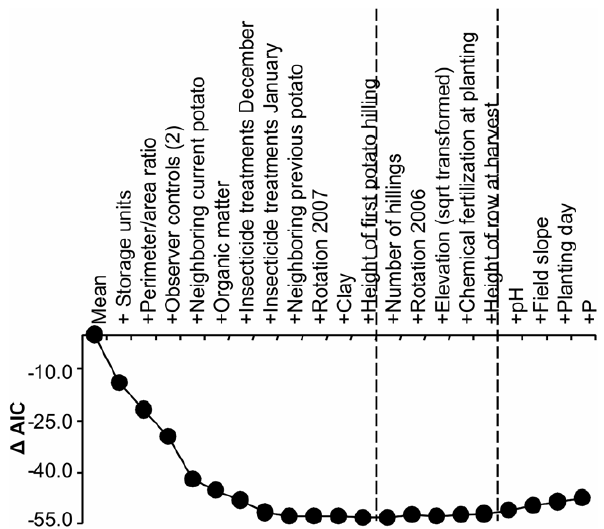
Figure 5. Forward stepwise development of the global (least parsimonious) statistical model explaining Andean potato weevil infestations. The x-axis shows the progressive addition of explanatory variables in order of their contributions to lowering AIC. The y-axis shows cumulative reductions in AIC from the AIC associated with using only the mean to estimate infestations. The first dashed line shows the point where the addition of variables started to penalize the AIC, whereas the second dashed line shows the point where this penalty started to exceed two AIC values. The global model included all variables before the second dashed line.